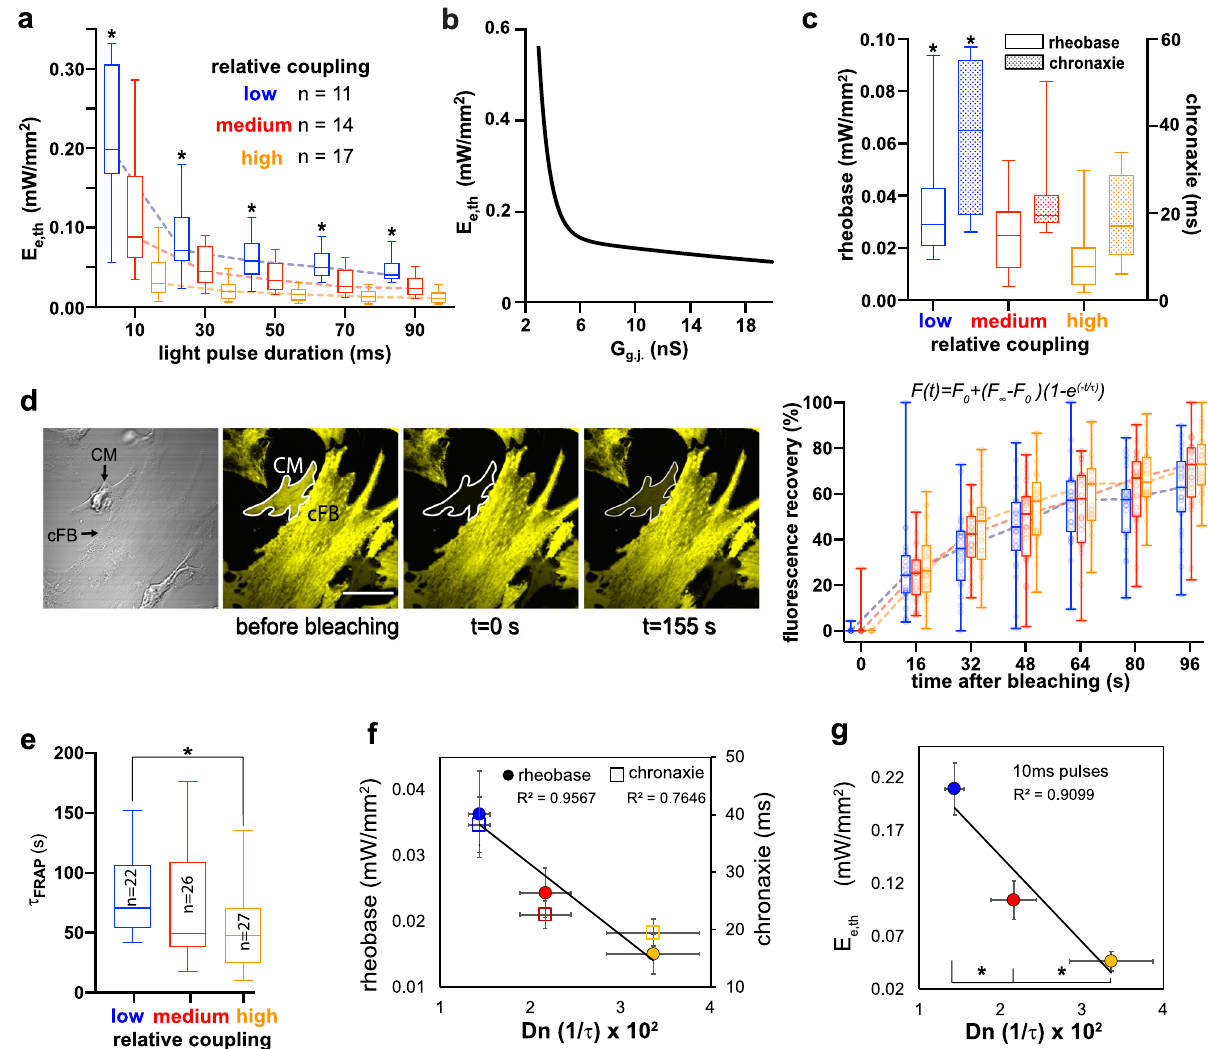
Figure 3. OptoGap performance and validation. ( a ) OptoGap response is quantified in terms of excitation threshold irradiances, E e,th , which vary as a function of optical pulse duration for the patterned experimental model from Fig. 2a,b (ChR2-cFB and CM), shown at three levels of gap junctional coupling strength. * indicates significant differences (p < 0.05) detected between the different coupling strengths: low (n = 11) medium (n = 13) and high (n = 16); normality of these distributions was confirmed. ( b ) A computational model of coupling between CM and ChR2-cFB predicts a distinct relationship between E e,th and gap junctional coupling G g.j. . Extended simulation results are shown in Supp. Figure 4. ( c ) OptoGap confirms computational predictions— illustration using key parameters: rheobase and chronaxie, extracted from the strength-duration curves in ( a ) by fitting the relationship rheobase . * indicates significant difference between the low coupling strength and the − xlog ( 2 ) 1 − e chronaxie other two coupling strength. ( d ) gapFRAP evaluation of coupling between ChR2-cFBs and CMs and recovery curves for these for the three levels of coupling. Scale bar is 50 µm. Dye fluorescence intensities obtained from sequential images of samples at three controlled coupling levels. In FRAP curves on the right are constructed using n = 22 samples for low, n = 26 samples for medium, and n = 27 samples for high coupling; the formula used to extract time constant τ FRAP is shown. ( e ) Extracted τ FRAP for each coupling condition is plotted, * significant difference, p < 0.05. ( f ) Cross-validation of OptoGap using standard gapFRAP. The lines are linear regression fitting rheobase and chronaxie mean value points, respectively. Data are presented as mean ± SE; the experimental data distributions for the rheobase and the chronaxie are shown in ( c ), while the data distribution for Dn is shown in Suppl. Figure 6. ( g ) OptoGap yields the highest sensitivity to coupling (higher than gapFRAP) at short pulses; E e,th for 10 ms pulses detected significant differences between all three coupling conditions (*); data presented as mean ± SE. Data distributions in panels ( a ), ( c ), ( d ) and ( e ) are presented as box-whisker plots including the median, the lower and upper quartile range, with whiskers covering the min– max range of the